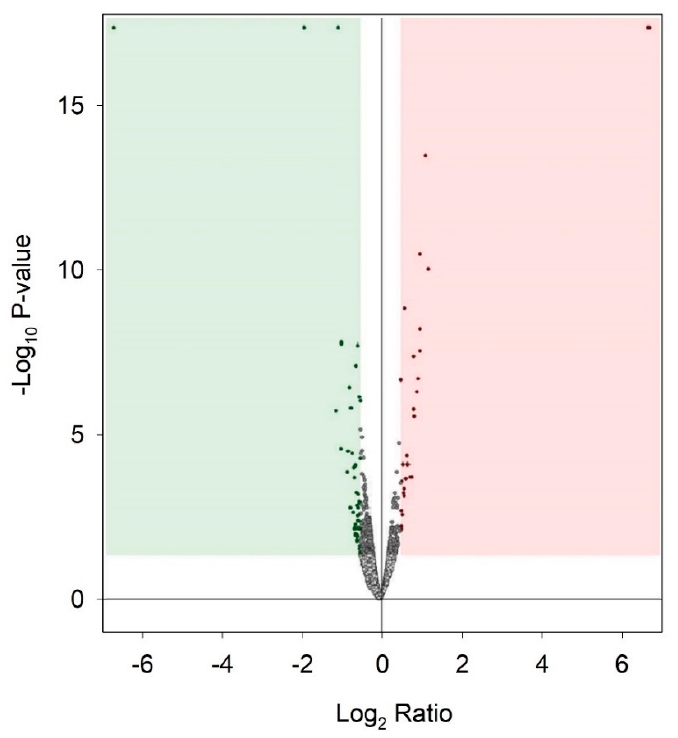
Figure 7. Effect of urea on protein expression in HMEC-1. Volcano plot that compares protein expression of cells treated with 0.25 g/L urea vs. 5 g/L urea for 72 h. Down-regulated proteins are in green. Up-regulated proteins are in red. Table 1. Differentially expressed (modulated) intracellular proteins following exposure of HMEC-1 to